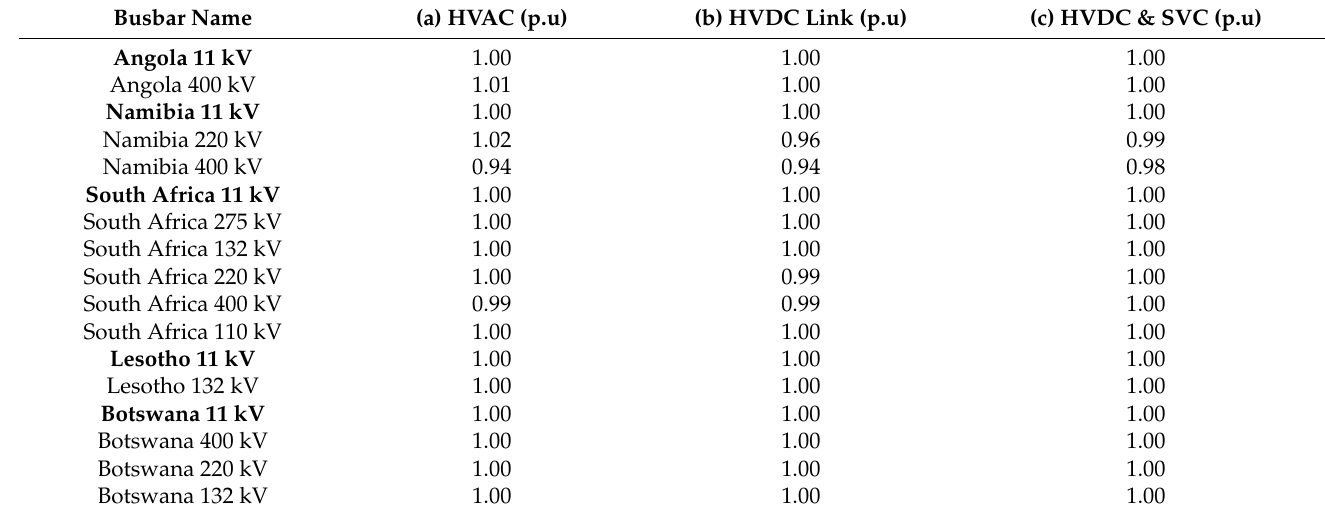
Table 4. Different busbar voltage profiles for the SARG